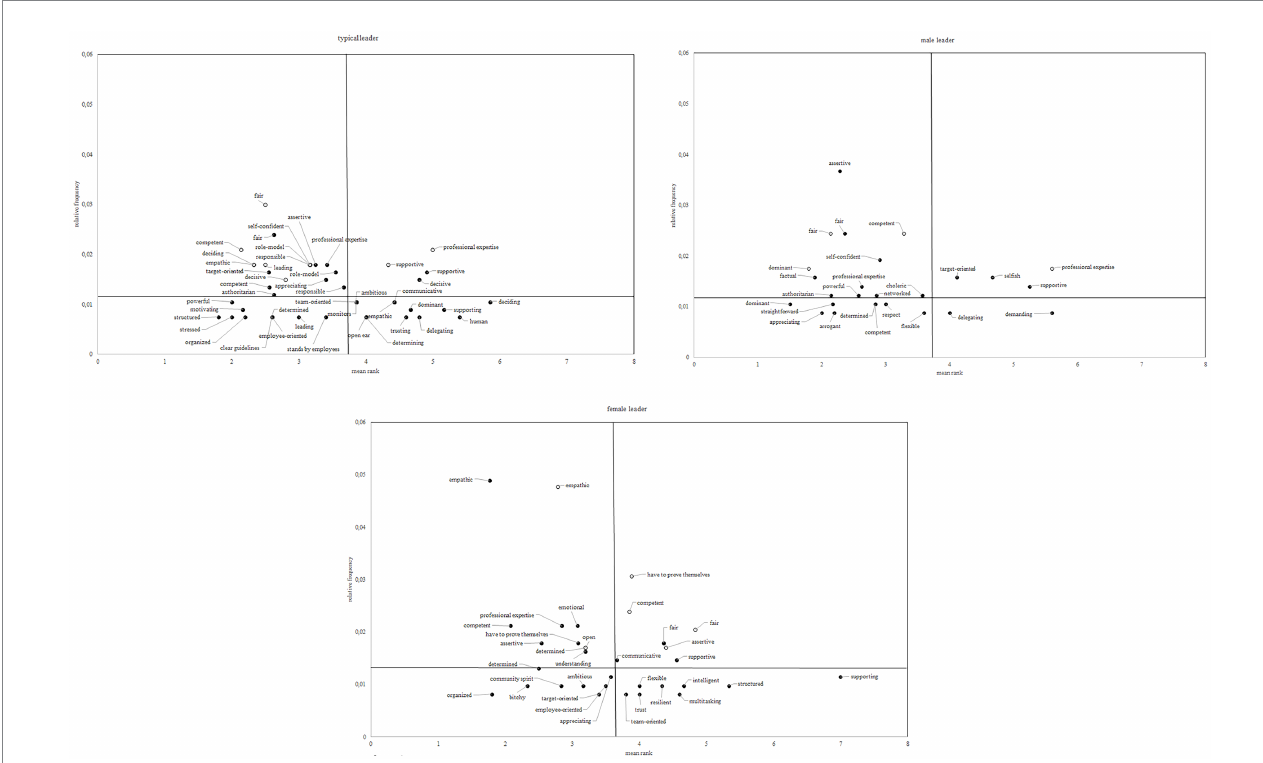
FIGURE 1 Relative frequencies and mean ranks of associations to the stimuli “typical leader,” “male leader,” and “female leader” by participants’ gender. Note: Only associations with frequencies above 4 were